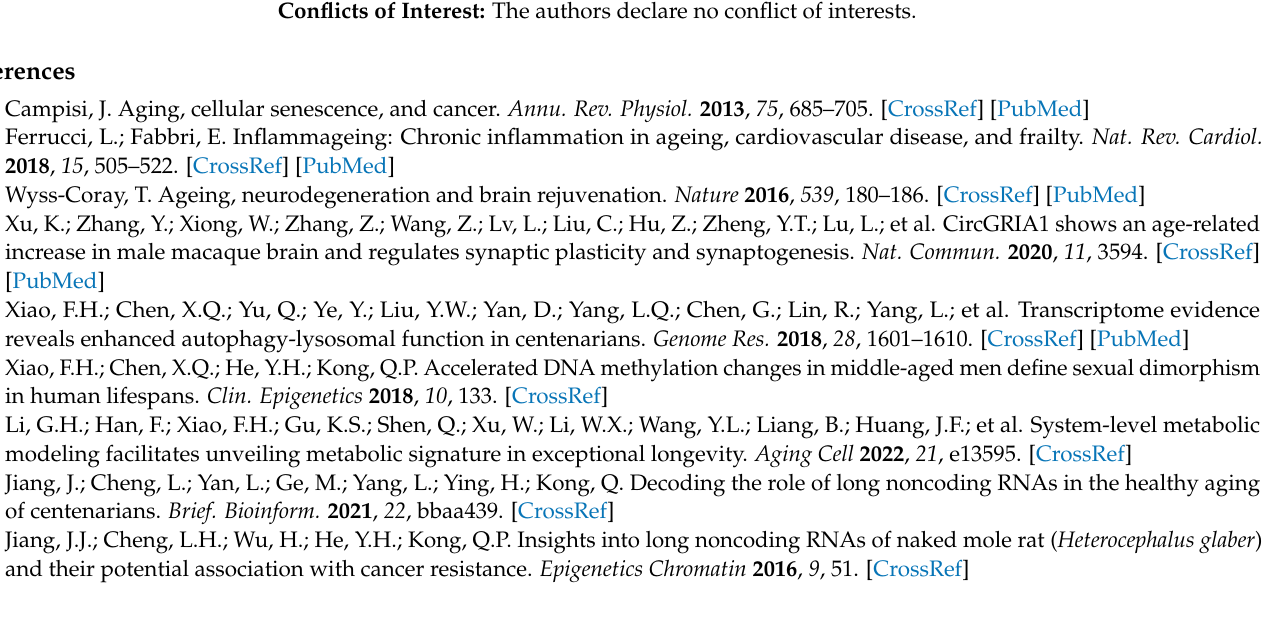
Figure S2: Pearson correlation analysis between age and cellular components of blood samples; Figure S3: Module preservation analysis; Table S1: Information and biological parameters (gender, age etc) of the participants enrolled in the study; Table S2: Full lists of detected circRNAs with high confidence in our study (n = 17,081); Table S3: Detailed information of circRNA co-expression modules obtained by WGCNA; Table S4: Results of Pearson correlation analysis between age